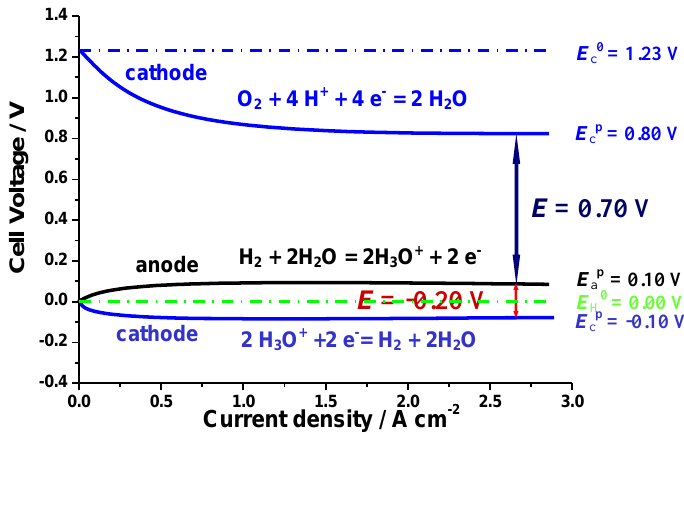
Figure 5. The formation of voltage reversal effect (VRE) in a